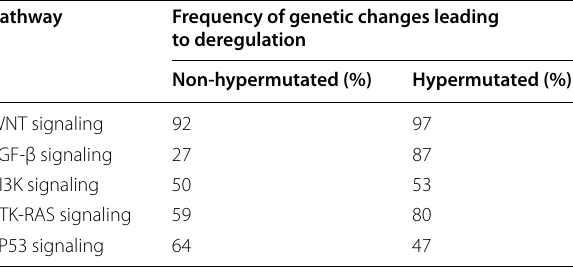
Reproduced from Fig. 4 in Nature 2012;487:330–7 authored by the Cancer Genome Atlas Network [61] with modifications, with permission WNT wingless/int-1, TGF-β transforming growth factor β, PI3K phosphatidylinositol 3-kinase, RTK receptor tyrosine kinase, RAS rat sarcoma viral oncogene homolog, TP53 tumor protein